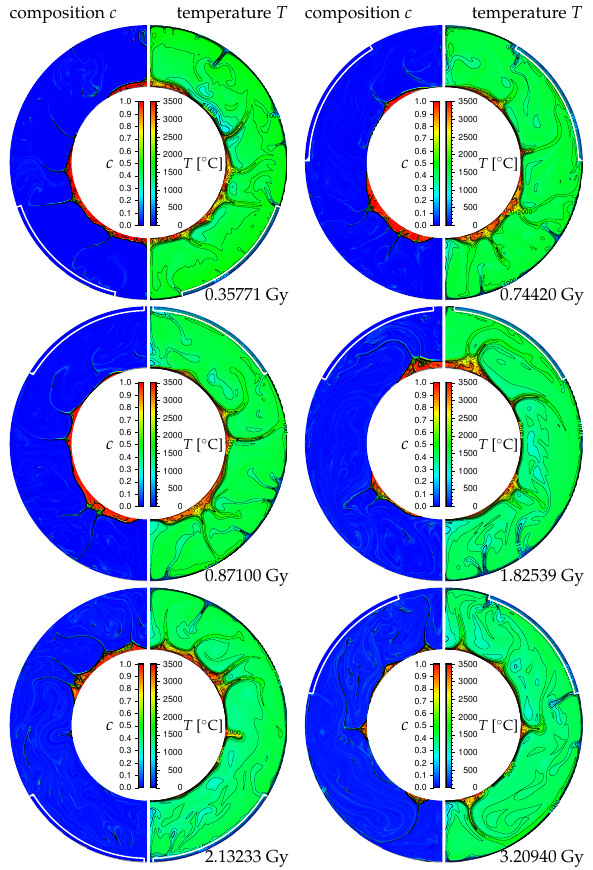
Figure 6. Same as Figure 4, but for Case